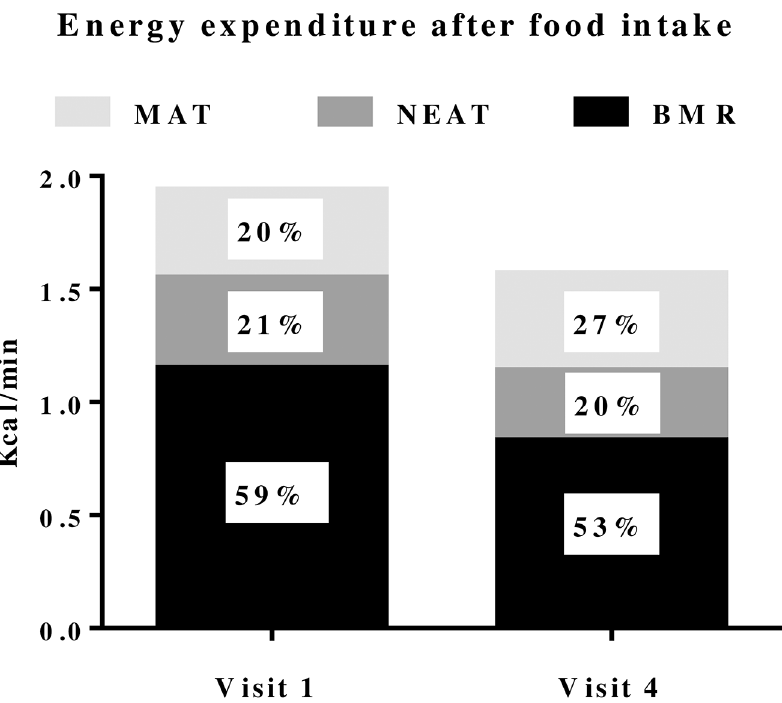
Fig 4. Six female subjects assessed for energy expenditure during one hour after a 600 kcal standard meal; from 18:20 to 19:20. Assessments were performed before, visit 1, and at weight stability 20 months after, visit 4, gastric bypass surgery. Data are presented as mean values in kcal/minute and as percentage of total energy